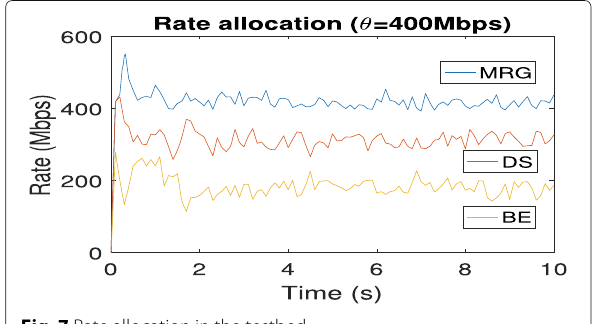
Fig. 7 Rate allocation in the